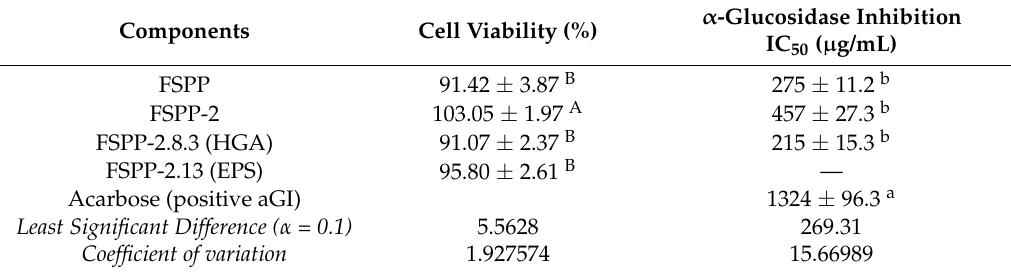
Table 3. Cytotoxicity and α -glucosidase inhibition of FSPP, FSSP-2, and its isolated compounds.